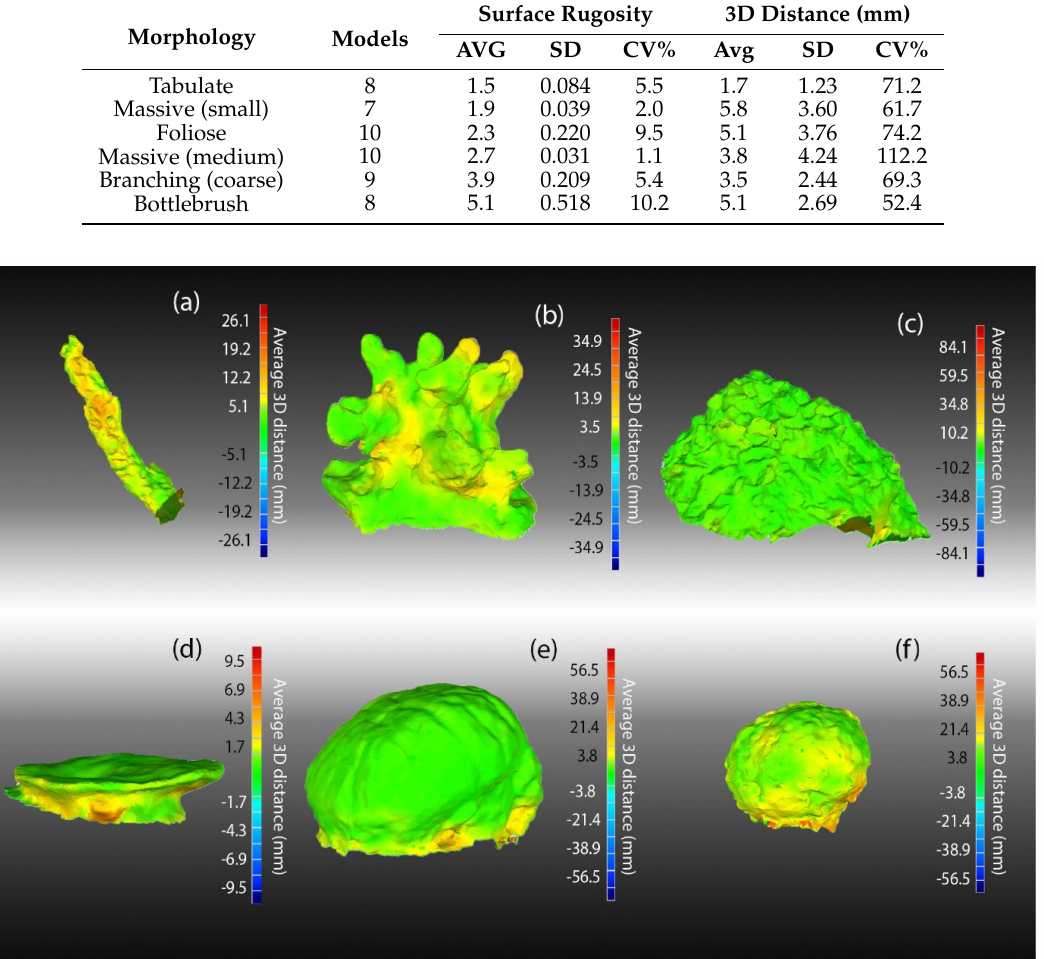
Figure 4. Precision analysis of 3D geometry of models of each morphology. The heatmap shows the spatial distribution of error (SD of average distance amongst models in mm) when all replicate models for each morphology were were compared using Geomagic Studio software deviation